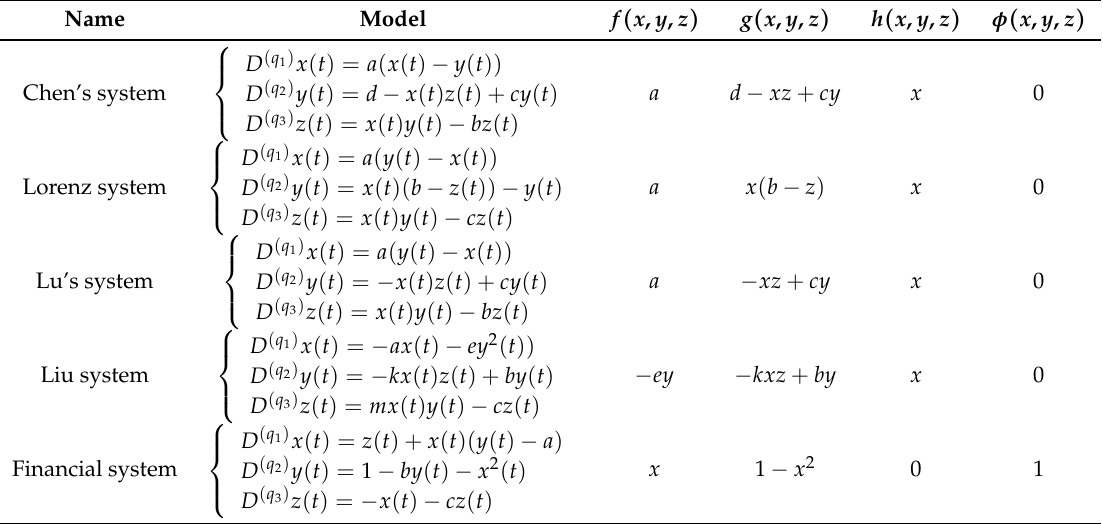
Table 1. Class of nonlinear fractional-order systems characterized by Equation